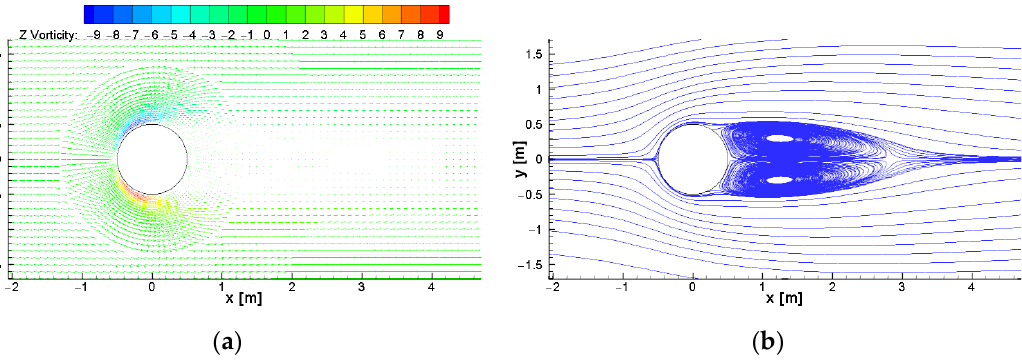
Figure 9. ( a ) Velocity vector fields and ( b ) streamlines around a circular cylinder ( Re = 100, t = 400 s).